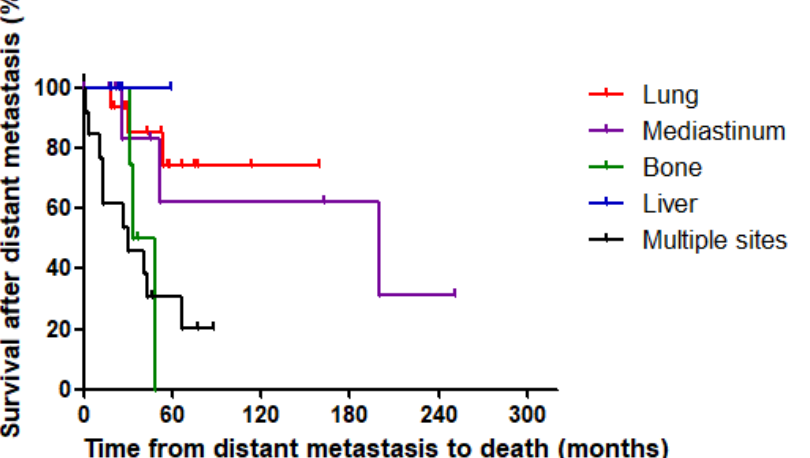
Figure 2. Survival after the detection of distant metastases according to the distant metastatic site (log-rank p = 0.007). Table 4. Survival rates from the detection of distant metastasis and HRs according to metastatic sites. Site of